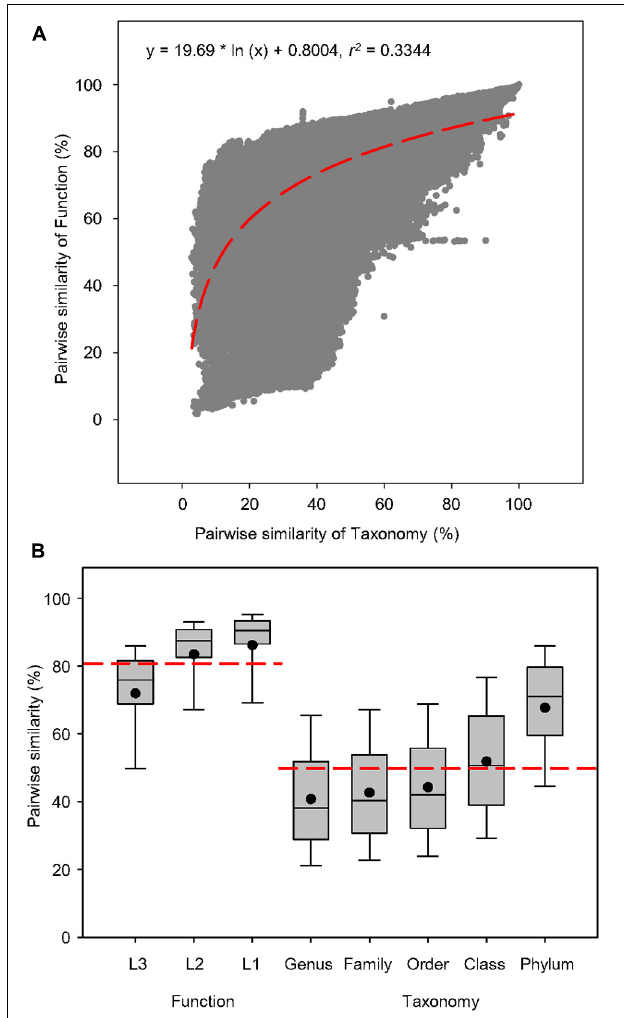
FIGURE 2 | Pairwise similarity of functional and taxonomic diversities. (A) Logarithmic regression between pairwise Bray-Curtis similarity of water metagenomes annotated in the Subsystems database at level 3 (Function) and RefSeq database at the genus level (Taxonomy). Regression equations and coefficients are given. The logarithmic regression line was shown as the red dashed line. (B) Box plots and mean values of pairwise Bray-Curtis similarity of water metagenomes annotated in the Subsystems database at levels 3, 2, and 1 (Function) and RefSeq database at genus, family, order, class, and phylum levels (Taxonomy). The mean values of pairwise Bray-Curtis similarity was shown as the red dashed